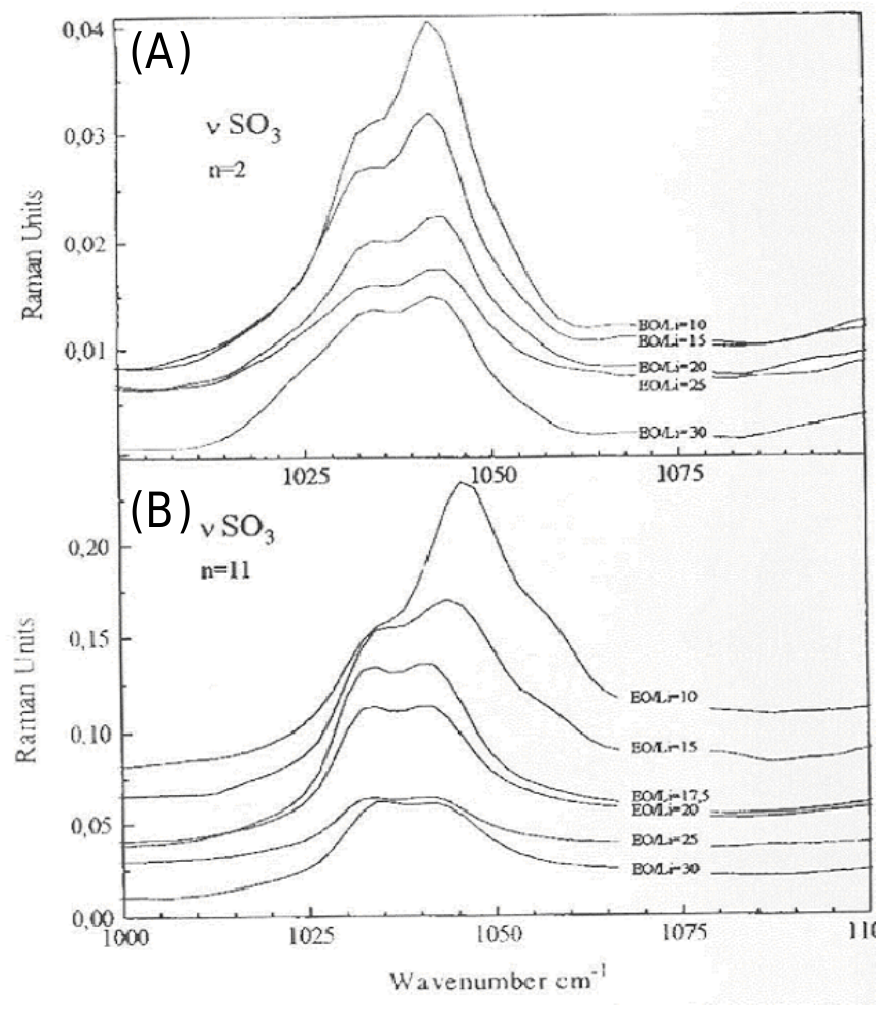
Figure 4. Raman spectra of dimethyl ethylene glycol with chain lengths 2 ( A ) and 11 ( B ) LiCF SO + (EG) DME at a concentration of EO/Li inverse molar ratio of LiCF 3 3 n elements of ethylene oxide oligomer from 10 to 30 at room temperature